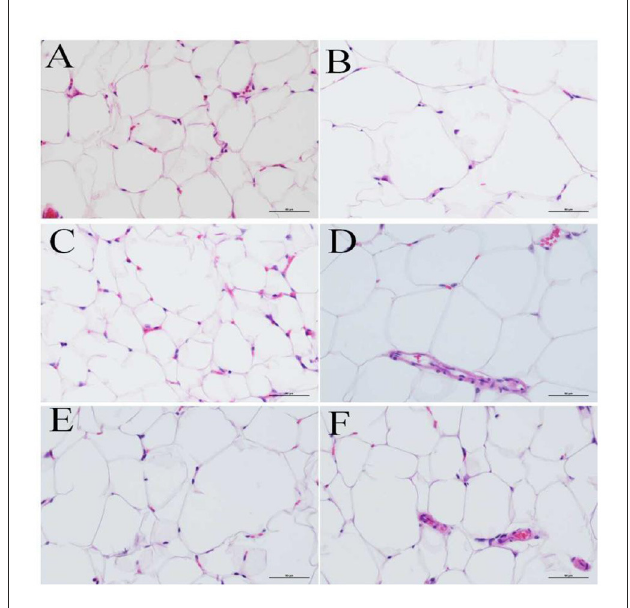
FIGURE4 Morphological observations of fat tissue in different groups of mice (hematoxylin–eosin staining, 400 × ). (A) Normal control (NC) group; (B) Model control (MOD) group; (C) Positive control (PC) group; (D) Low-dose Pleurotus eryngii polysaccharide (LPEP) group; (E) Medium-dose Pleurotus eryngii polysaccharide (MPEP) group; and (F) High-dose Pleurotus eryngii polysaccharide (HPEP)